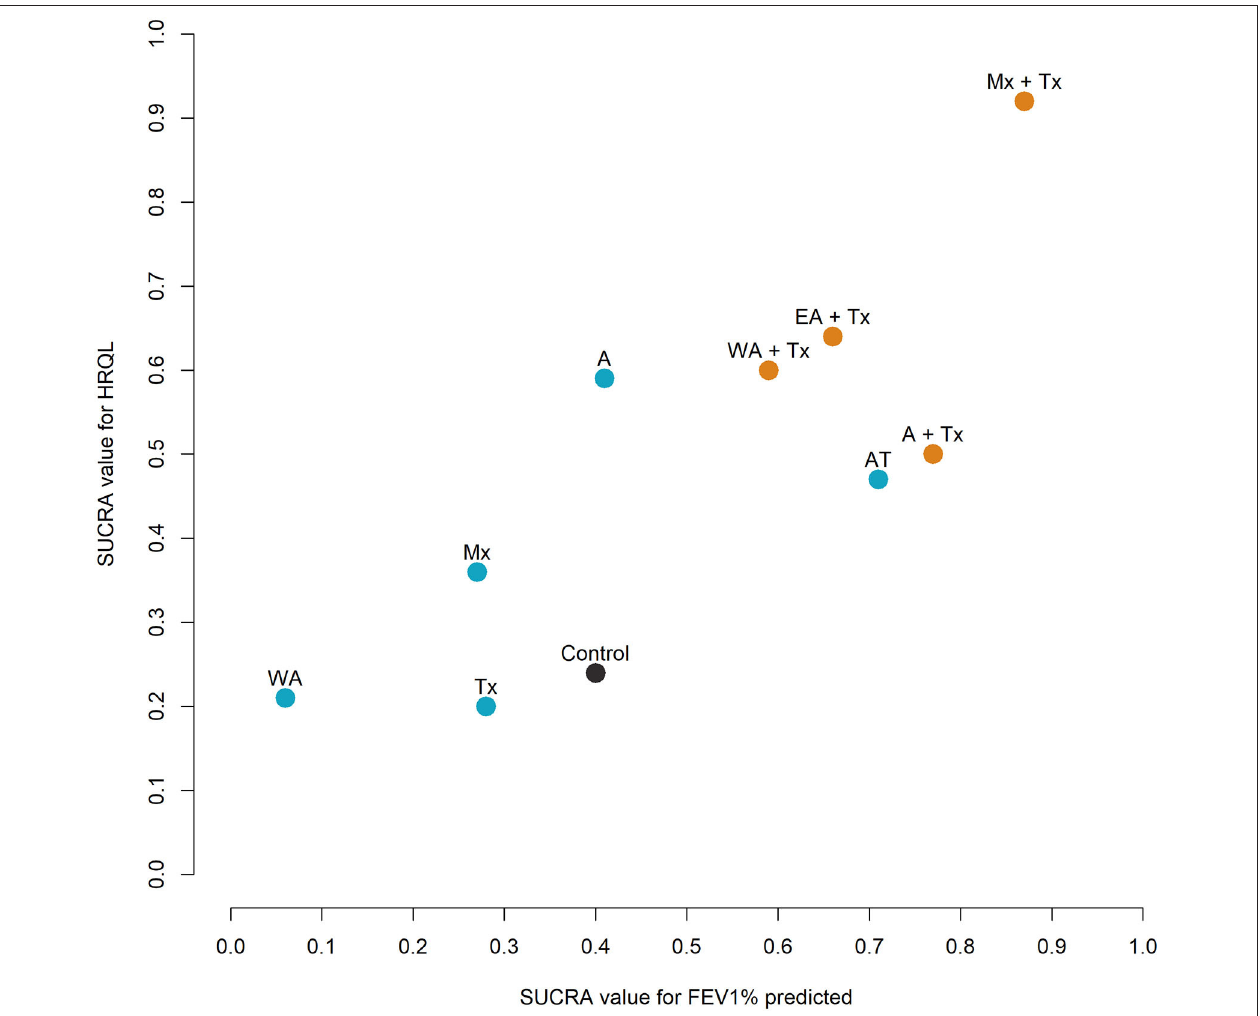
FIGURE 4 | Clustered ranking plot. The plot is based on cluster analysis of surface under the cumulative ranking curves (SUCRA) values. Each plot shows the SUCRA values for two outcomes: health-related quality of life (HRQL) and FEV1%. Treatments lying in the upper right corner are more effective in HRQL and FEV1% than the other treatments (dot color: orange: acupuncture point stimulation treatment combined with conventional treatment; blue: single intervention; black: